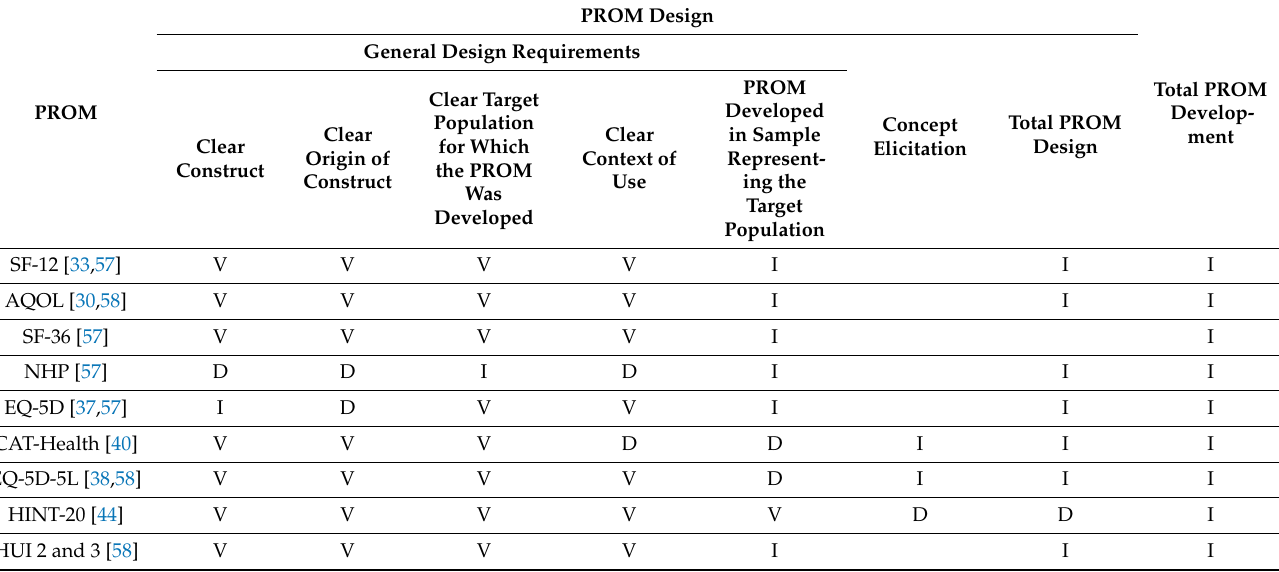
Table 7. Quality of PROM development and concept elicitation